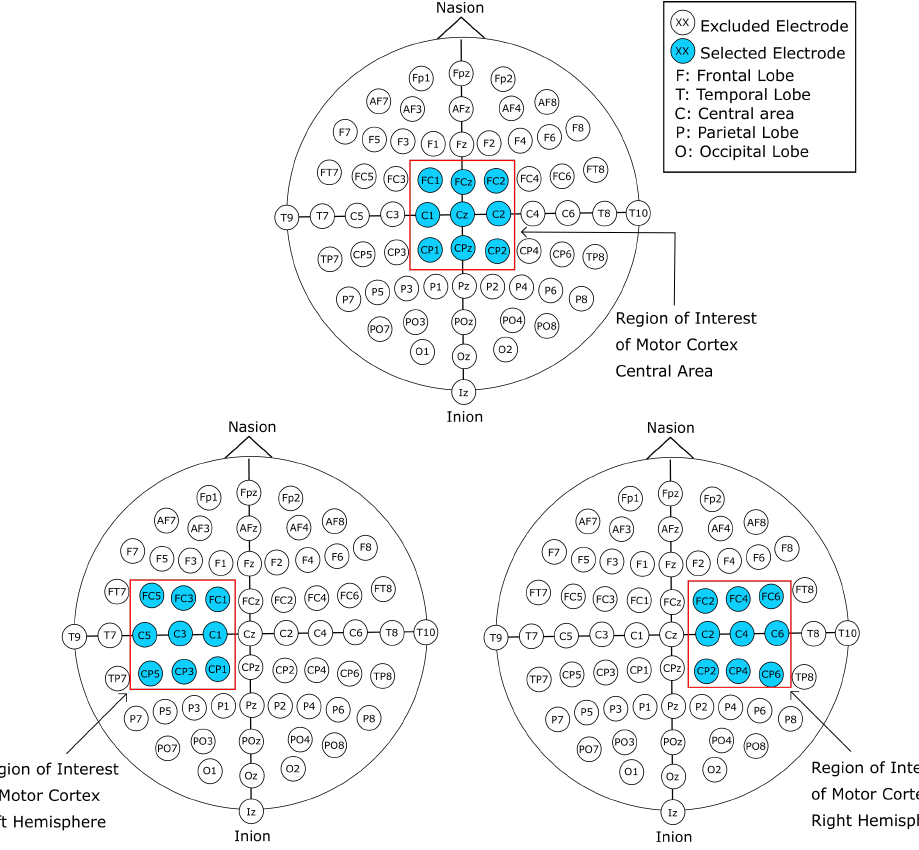
Figure 10. The 9-channel arrangement of electrodes selected for third variant vertically stacked spectrograms